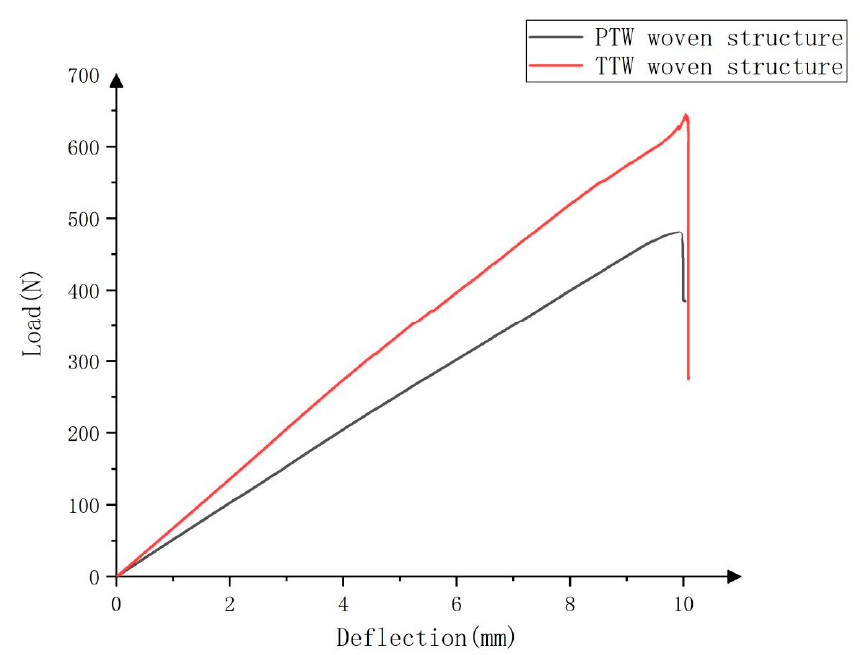
Figure 12. Deflection–load curves of the two structures.